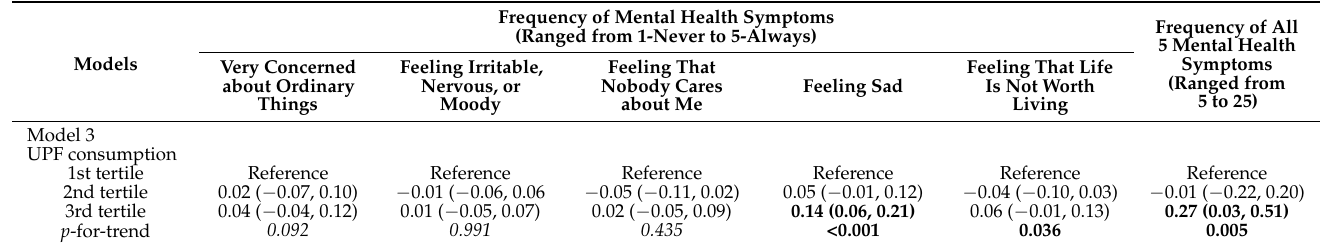
* Values are ß -coefficients (95% confidence intervals) obtained through generalized linear models. Values in bold indicate statistically significant results ( p <0.05). Model 1: adjusted by age (>15 vs. 13–15 years), self-reported race (white vs. nonwhite), socioeconomic condition (lower [1st quartile] vs. moderate or higher [2nd to 4th quartiles]), school location (urban vs. rural), school administration (public vs. private), and educational level (secondary vs. primary). Model 2: previous model adjusted by parental living (both parents vs. one or no parent), having meals with parents (always or almost always vs. lower frequency), number of close friends ( ≥ 3 vs. <3), free-time